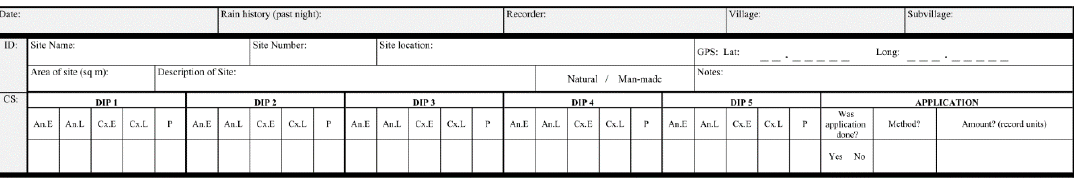
Figure 2. Site form filled out by larviciding staff at each larval breeding site identified.